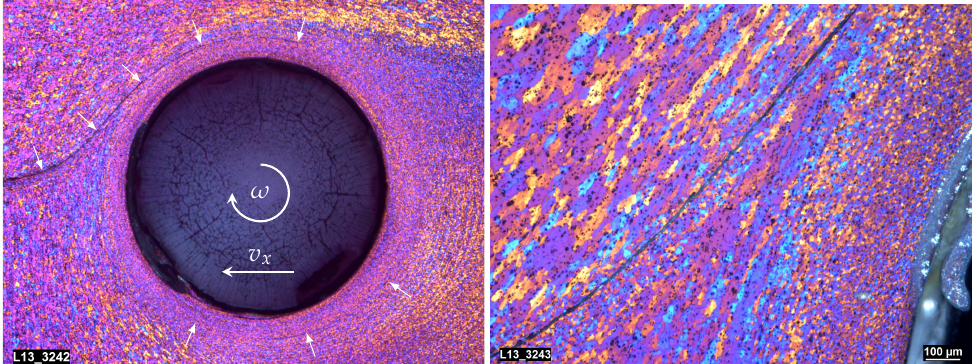
Figure 9. Co-rotating material flow around and initial deformation zone in front of the tool. Oxides of the former joint line are dragged into the joining zone and mechanically disintegrated (white